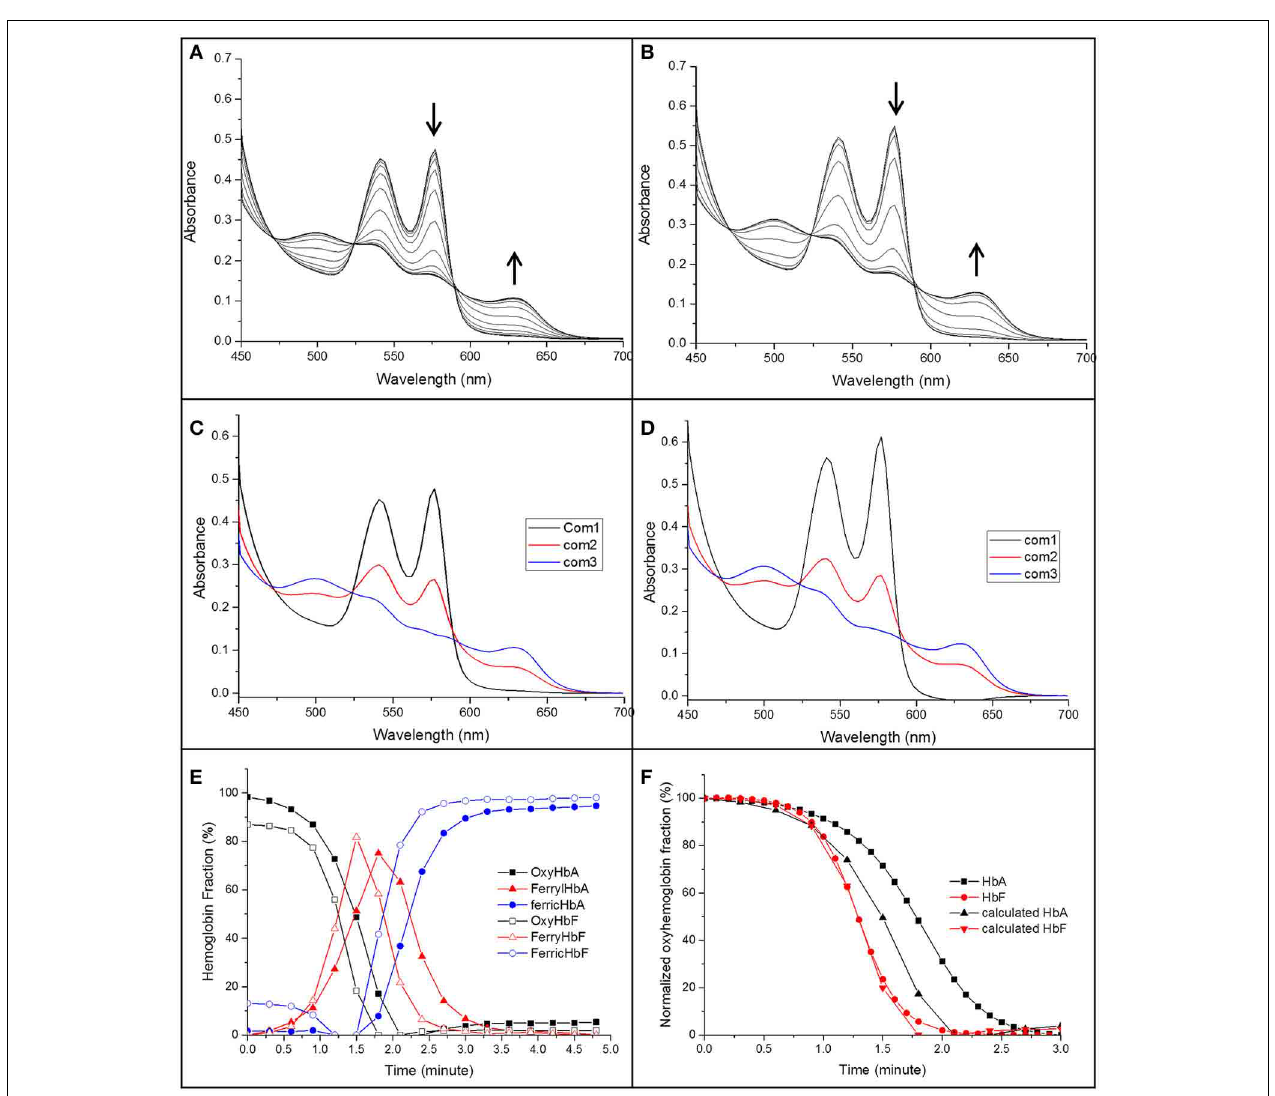
FIGURE 7 | The spectra of the reaction between 40 μ M of oxyHb and 1mM NaNO 2 in 20mM sodium phosphate buffer buffer pH 7.4 at 25 ◦ C (A: HbA, B: HbF). The spectra were recorded in the 450–700nm region every 18s. The decrease of oxyHb and the increase of ferric Hb during the reaction are indicated by arrows. A derived spectra component